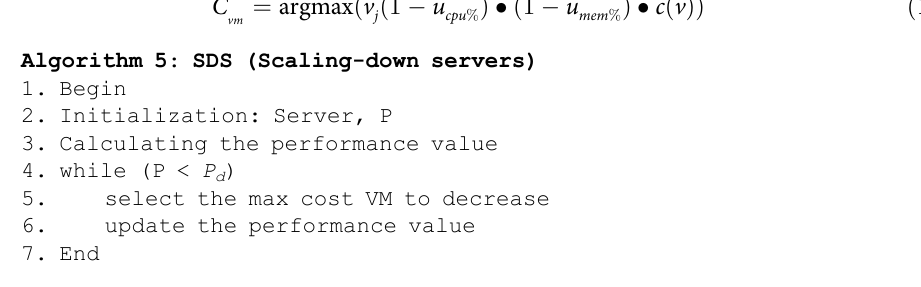
Algorithm 5 : SDS (Scaling-down